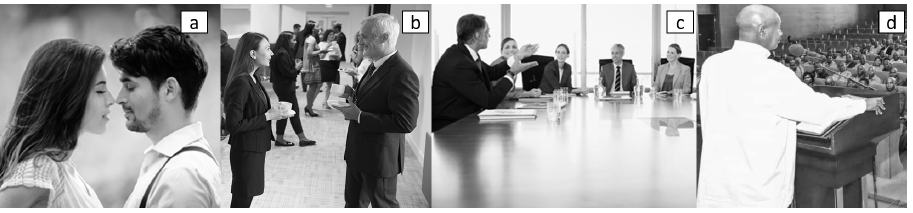
Figure 2. Interaction according to Proxemic zones: ( a ) intimate, ( b ) personal, ( c ) social and ( d )